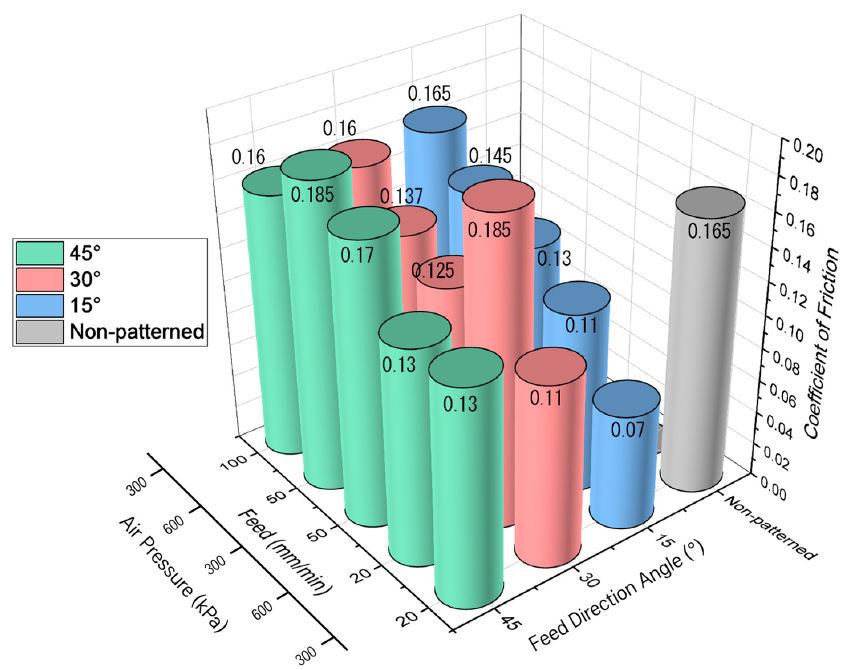
Figure 15. Coefficient of friction due to changes in traverse-direction angle of micro-AAJ machining at 200